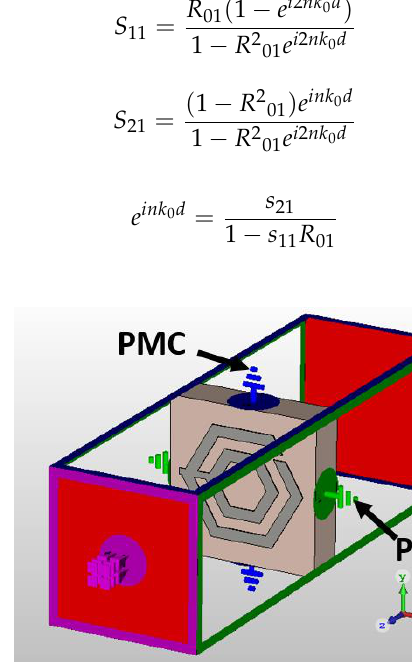
Figure 2. Simulation setup of the proposed HSRR structure.